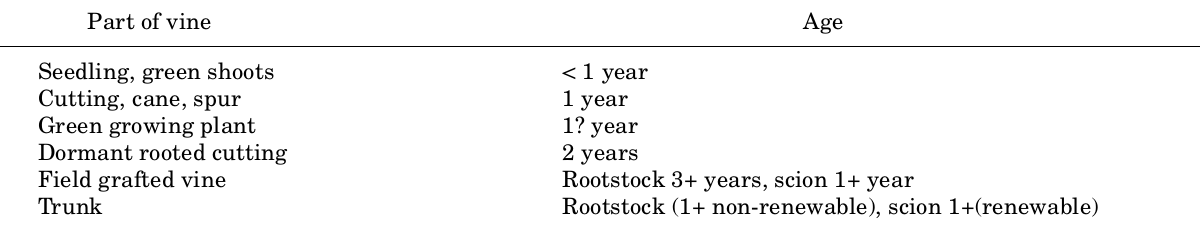
Table 2. Parts of the vine and their age. Part of vine Age Seedling, green shoots < 1 year Cutting, cane,